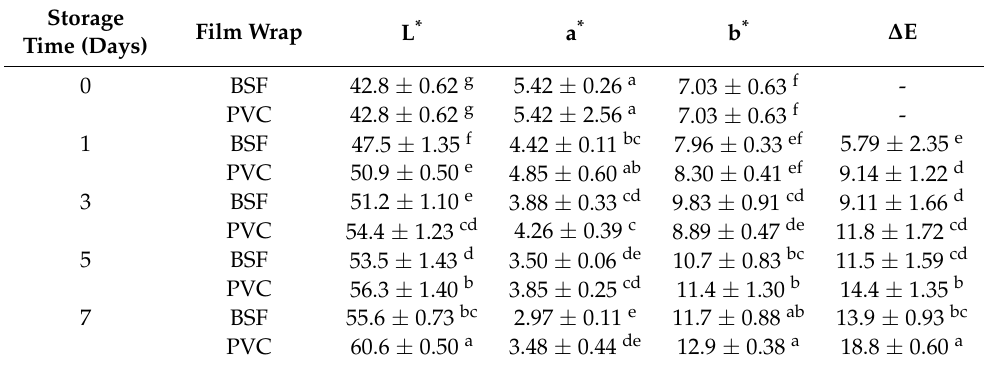
Table 4. Color attributes of wrapped minced pork during refrigeration (4 ± 1 ◦ C) for 7 days.